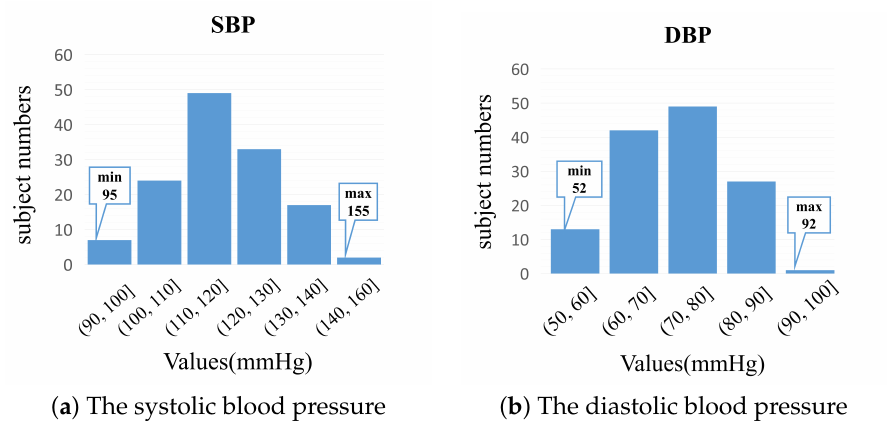
Figure 3. The distributions of the ground-truth blood pressure values in the MPM-BP